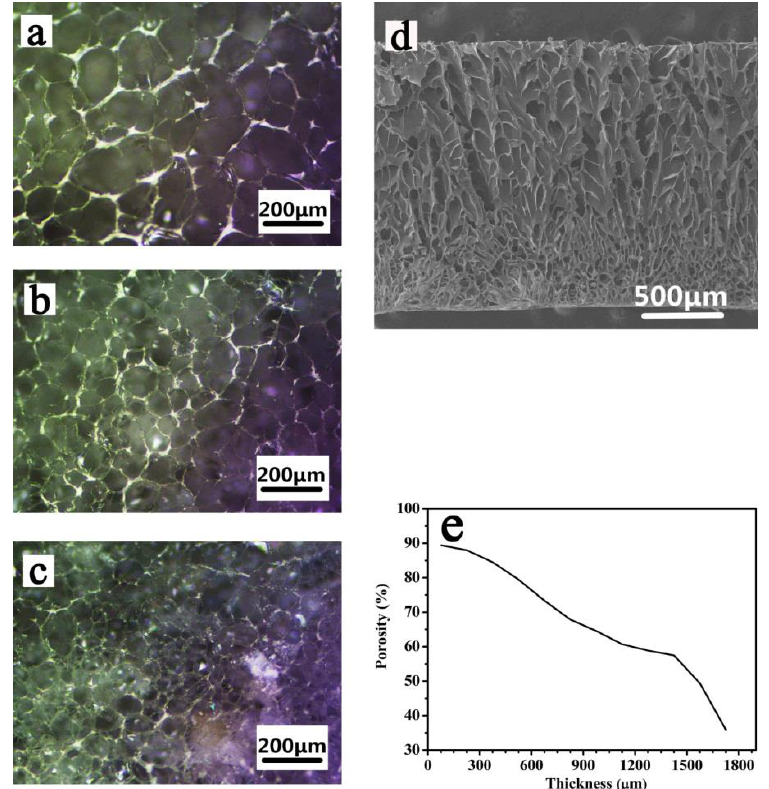
Figure 4. Pore morphologies of the gelatin substrate. ( a ) At the top; ( b ) in the interlayers; ( c ) at the bottom; ( d ) the vertical section; ( e ) porosity of gelatin substrate from top to bottom.